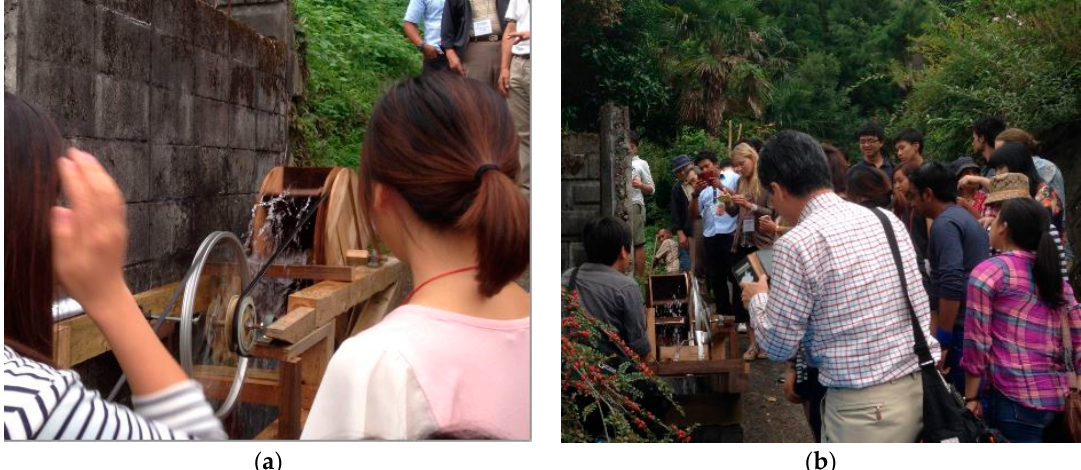
Figure 1. (a) Handmade micro-hydropower by farmers and local people in Gokase. ( b ) Installation of the community-based micro-hydropower plants called ‘Kincir’ led by local residents and farmers in Gokase (photo by T. Fujimoto, International workshop on micro-hydropower for community development, 26–27th, SEP, 2015, Gokase, Miyazaki Prefecture, Japan).